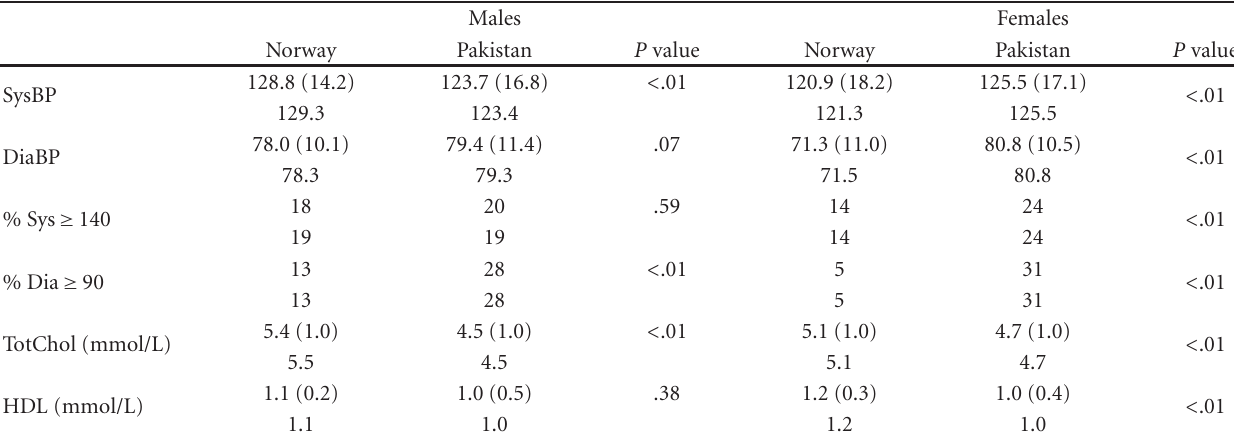
Table 3: Di ff erences in clinical features among Pakistanis in Oslo and in Pakistan. Numbers are mean values with one SD in brackets. P values for di ff erence between Pakistanis and Norwegian-Pakistanis. Age adjusted values below.